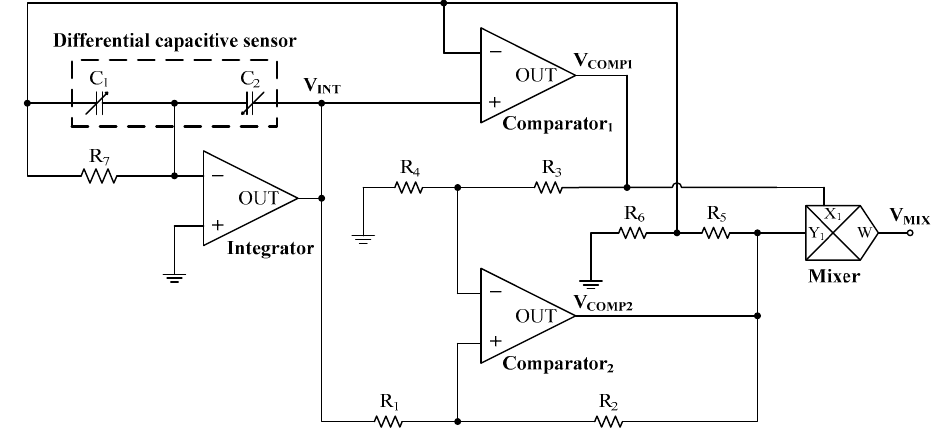
Figure 2. Schematic circuit of the proposed electronic interface for differential capacitive sensors.